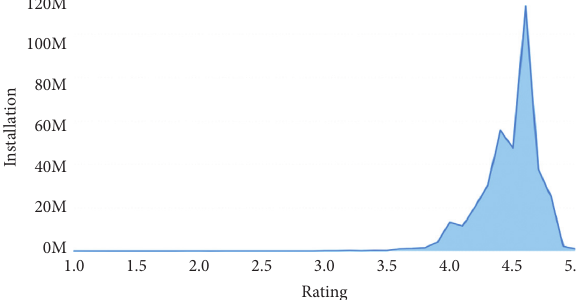
Figure 5: Relationship between app rating and the number of installs.